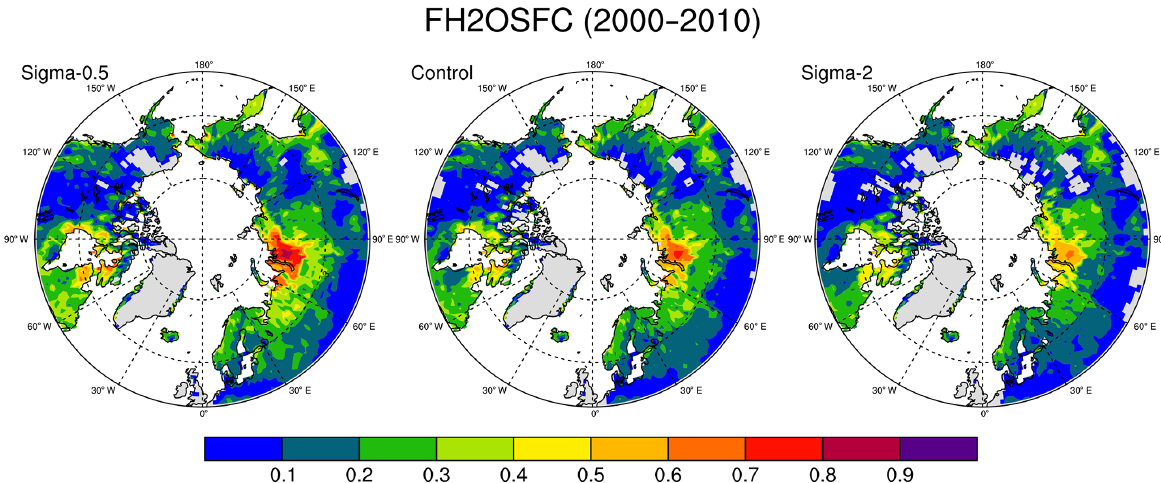
Figure 1. High-latitude ( > 50 ◦ N) maps of simulated surface water fractions ( f h2osfc ) from the Control, Sigma-0.5, and Sigma-2.0 experi- ments with different σ micro distributions averaged for the period